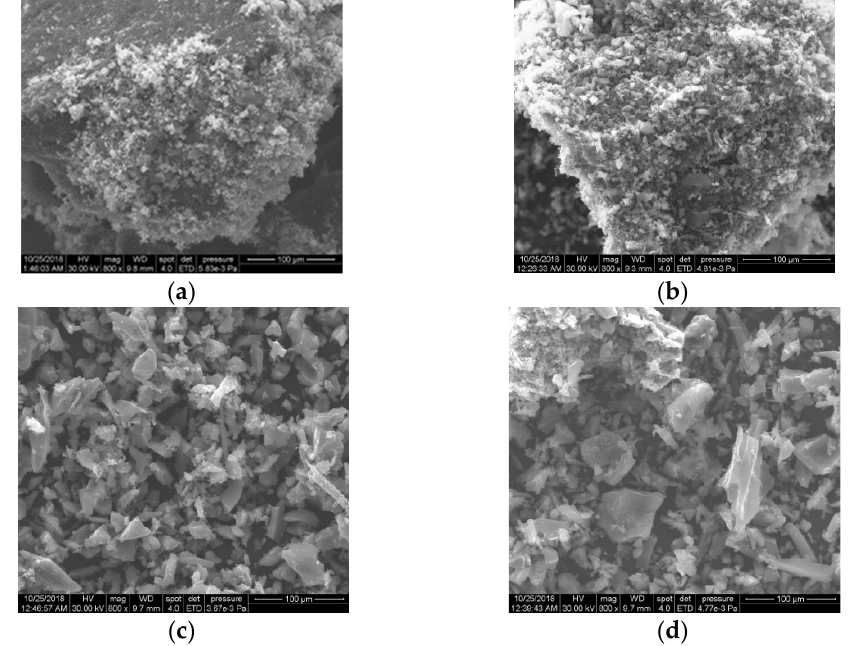
Figure 7. The SEM images of the magnetic nanocomposites PM1 ( a ), PM2 ( b ), PM3 ( c ) and PM4 ( d ).